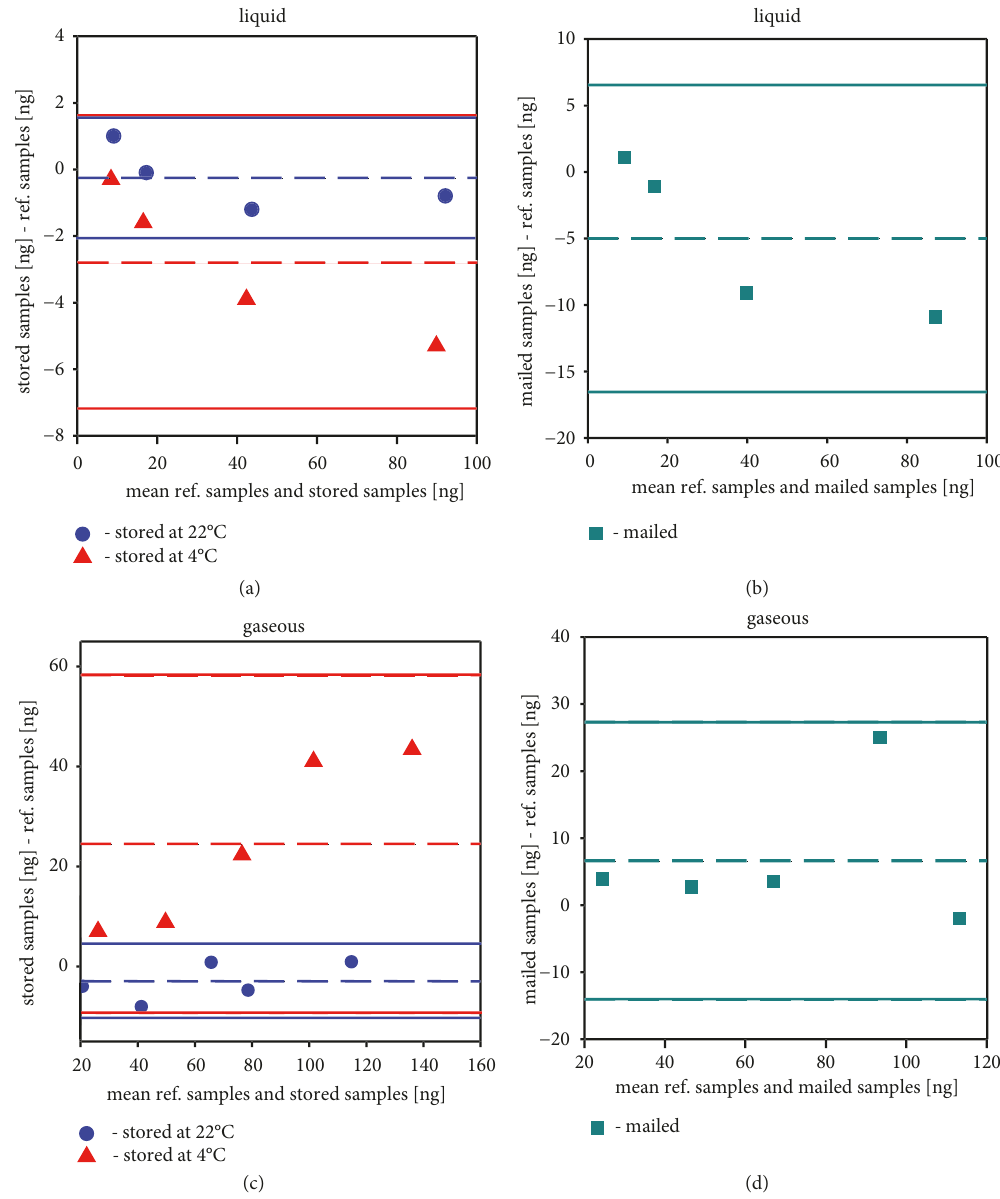
Figure 4: Comparison of stored (a, c) and mailed (b, d) samples with the reference Tenax tube samples for both application methods: liquid (a, b) and gaseous (c, d). Difference plots with stored samples (22 ∘ C blue dots; 4 ∘ C red triangles) vs. direct measured reference samples (a, c) and mailed samples vs. direct measured reference vs. (turquoise rectangles) (b, d). The dashed lines represent the mean of the differences and the solid lines represent the mean of the difference ± 1.96